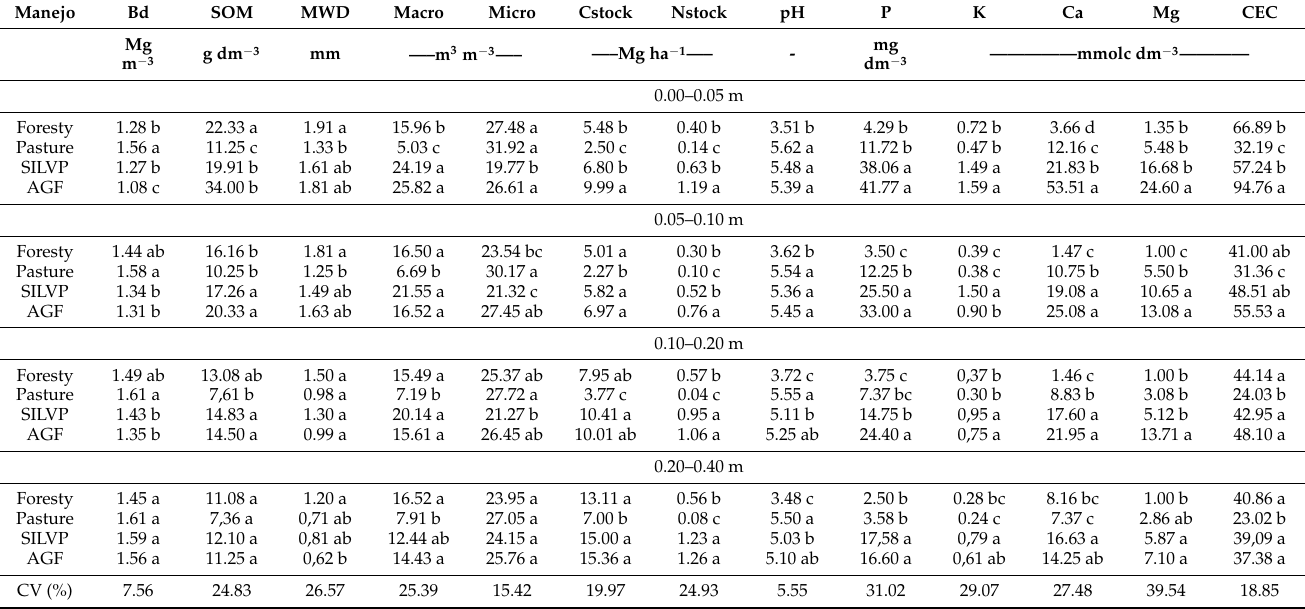
Table 2. Mean values of physical and chemical soil attributes under different land use and manage- ment systems in a large-scale ecological farm, municipality of Itirapina, S ã o Paulo,